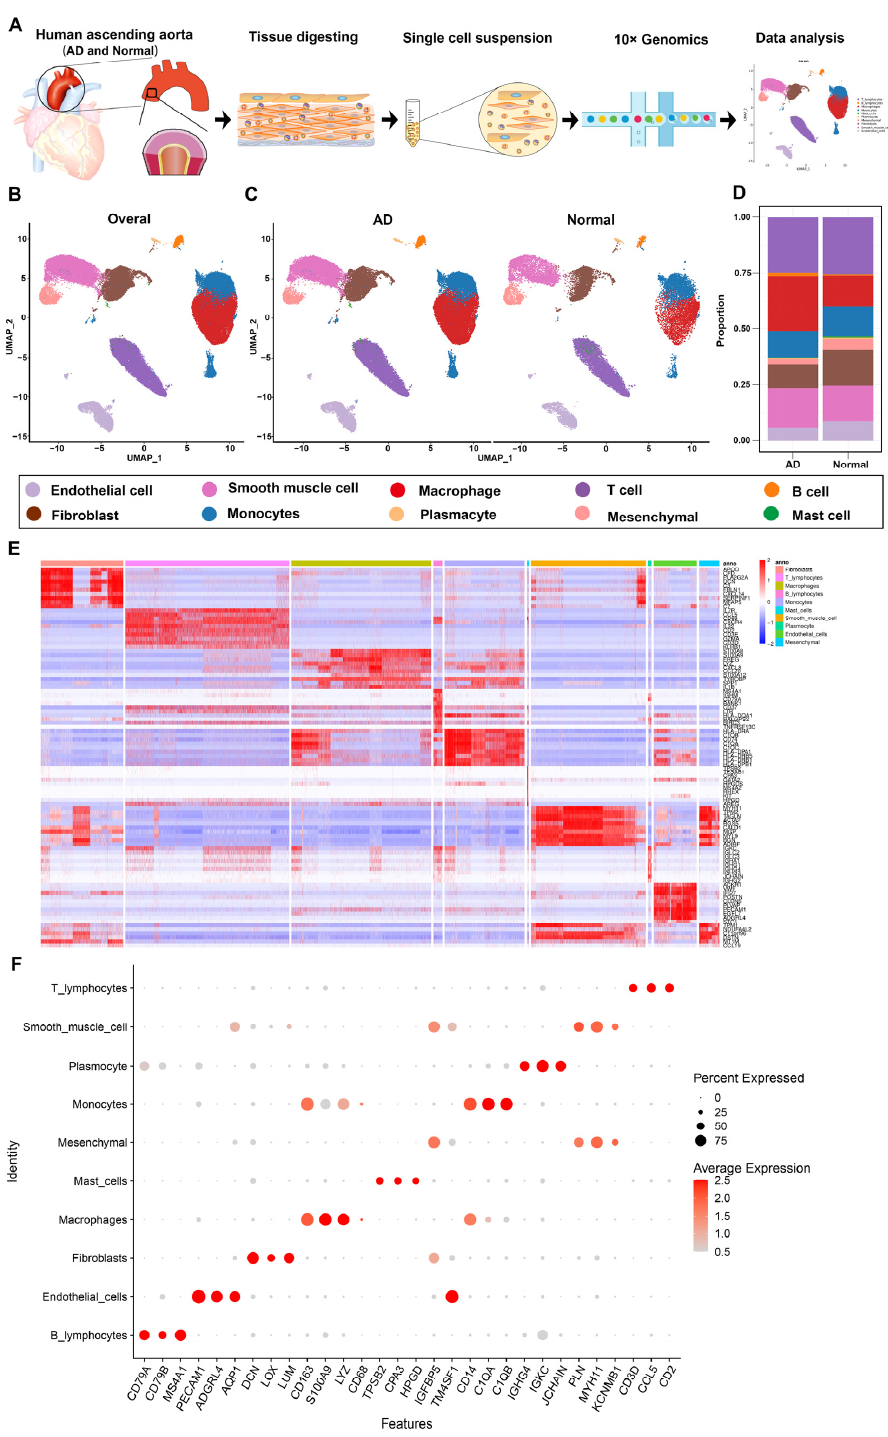
Figure 1. Single-cell atlas of AD and normal ascending aorta samples. ( A ) Schematic diagram of the sample processing and experimental workflow employed. ( B ) UMAP plot of the 79,544 cells profiled, including ten main cell types in nine samples. Below the graph are legends color-coded by the assigned cell type. ( C ) UMAP plots of the AD group (six samples) and normal group (three samples). ( D ) Bar plot depicting the proportions of the ten main cell types in the AD and normal groups. ( E ) Heatmap of the top ten DEGs for the ten main cell types. ( F ) Dot plot of selected marker genes for each cell type. The dot size represents the percentage of cells expressing each gene, while the dot color represents the level of expression. UMAP, uniform manifold approximation and projection; DEGs, differentially expressed